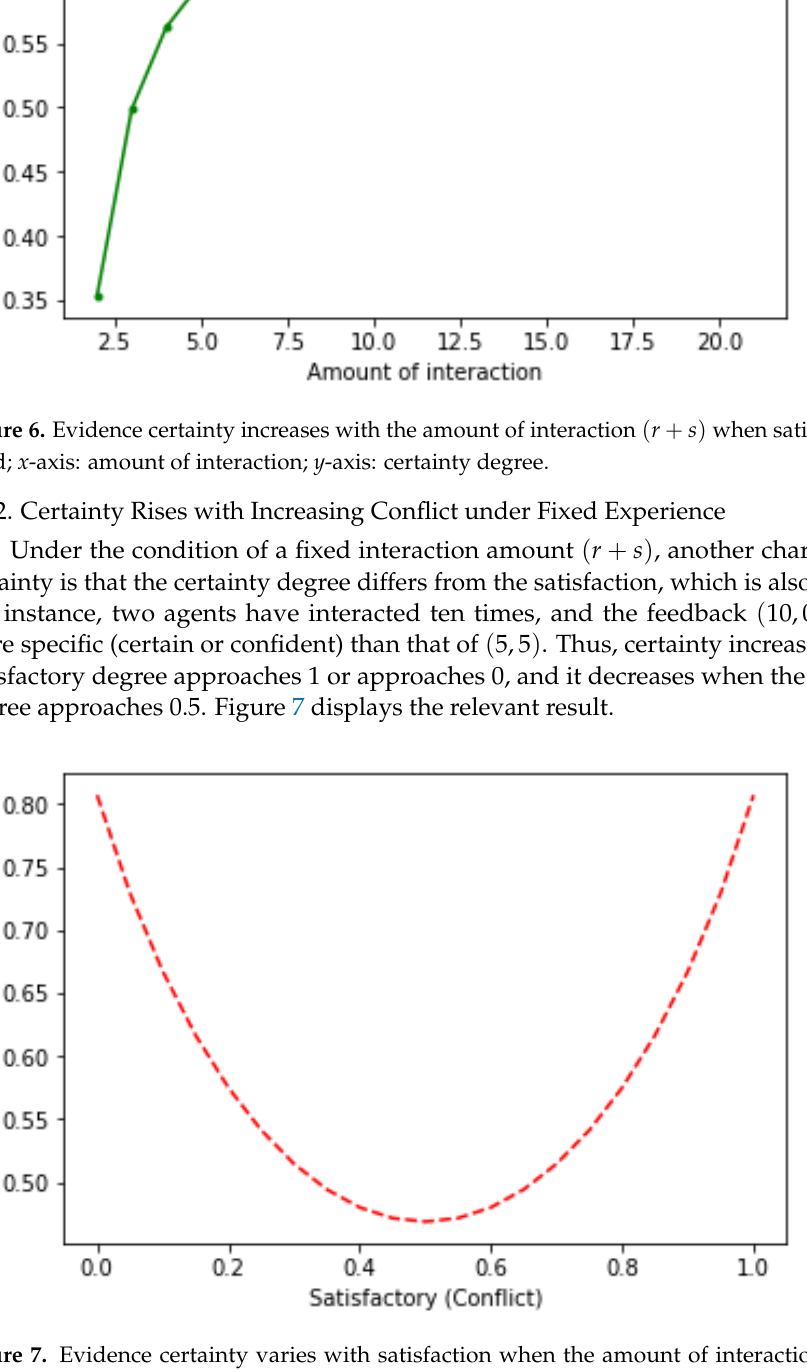
Figure 7. Evidence certainty varies with satisfaction when the amount of interaction 20 is fixed, and the satisfactory degree 0.5 leads to the lowest